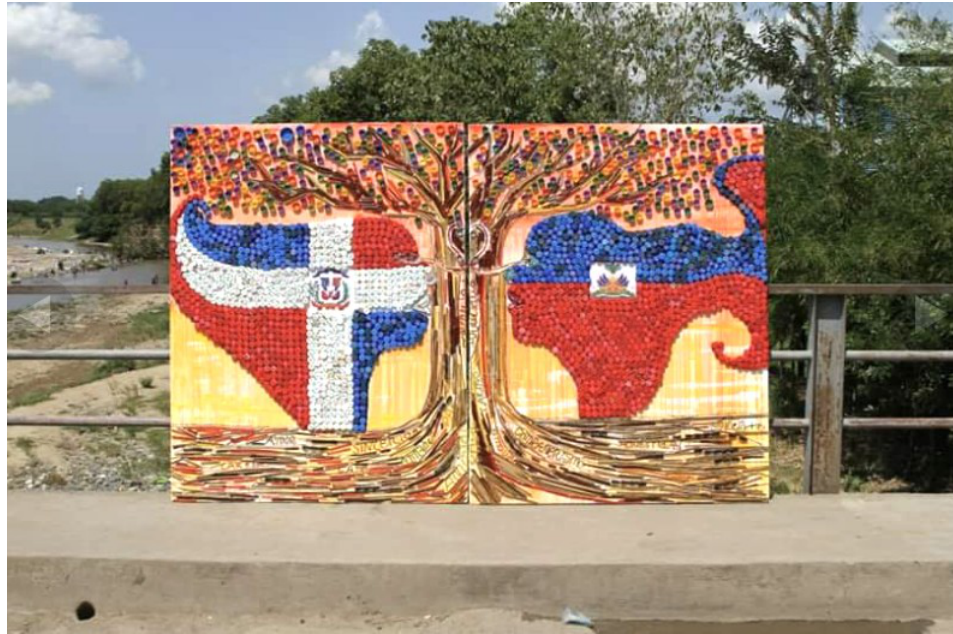
Detail of Mural de Amistad, photography by E. Suero,